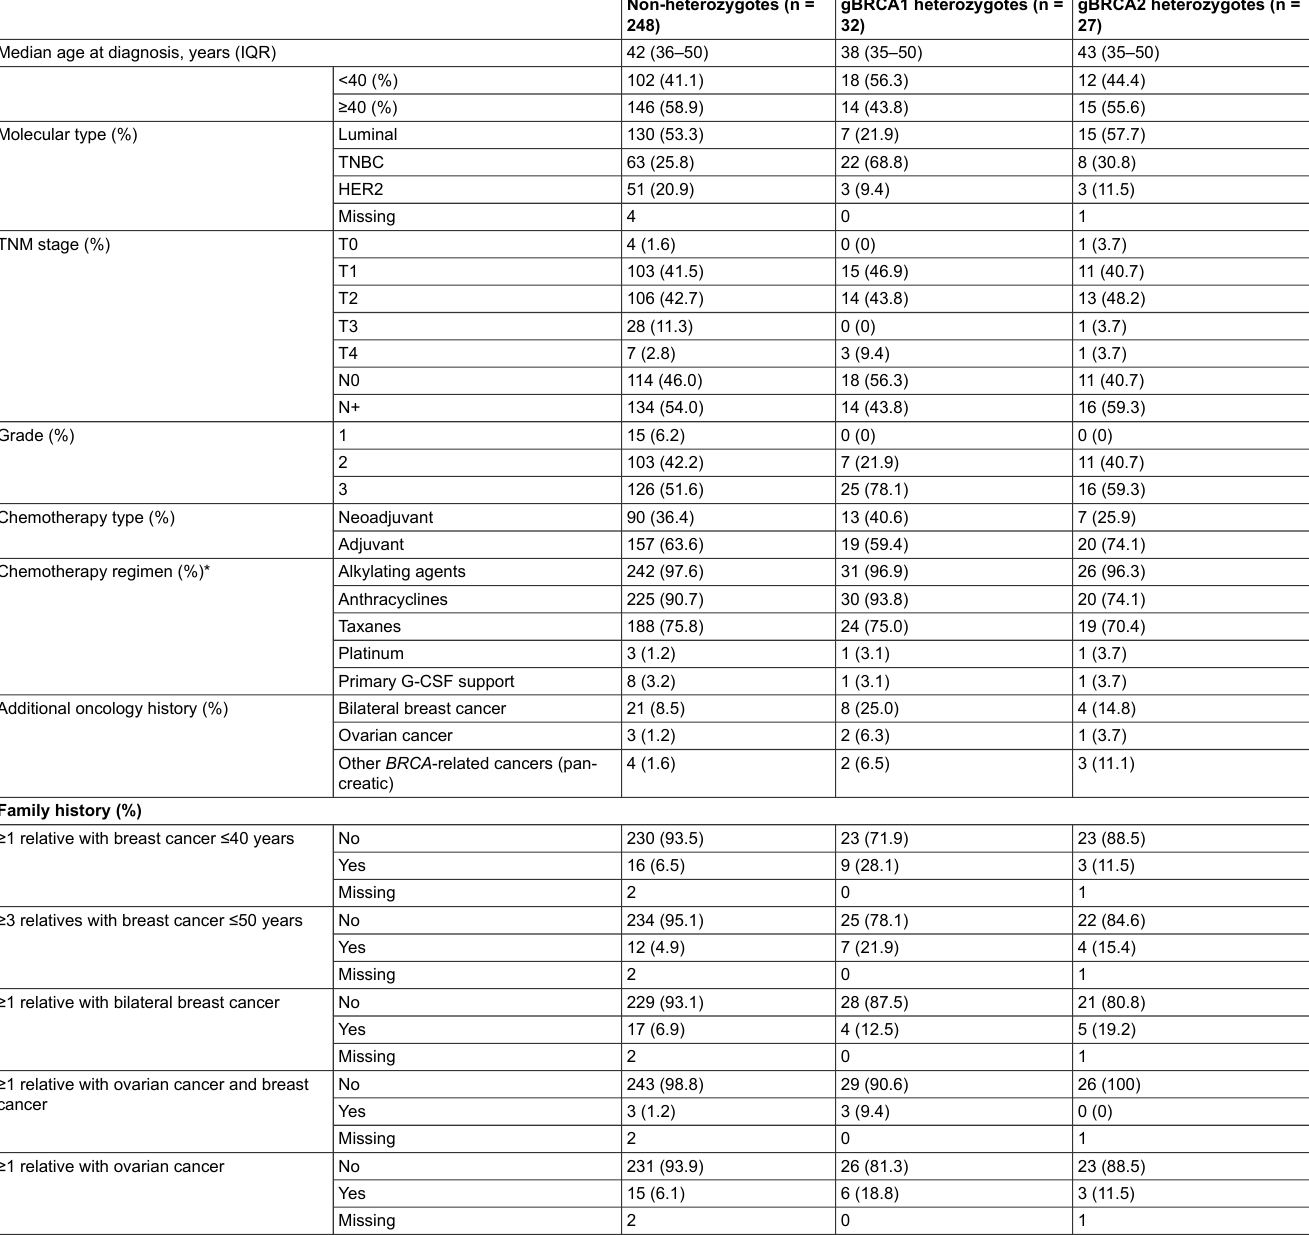
IQR: interquartile range; TNBC: triple-negative breast